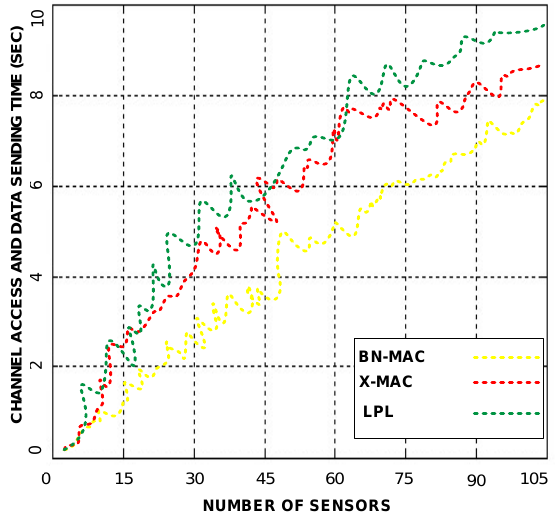
Figure 8. Channel accessing and data delivery time for BN-MAC and other low-duty-cycle MAC